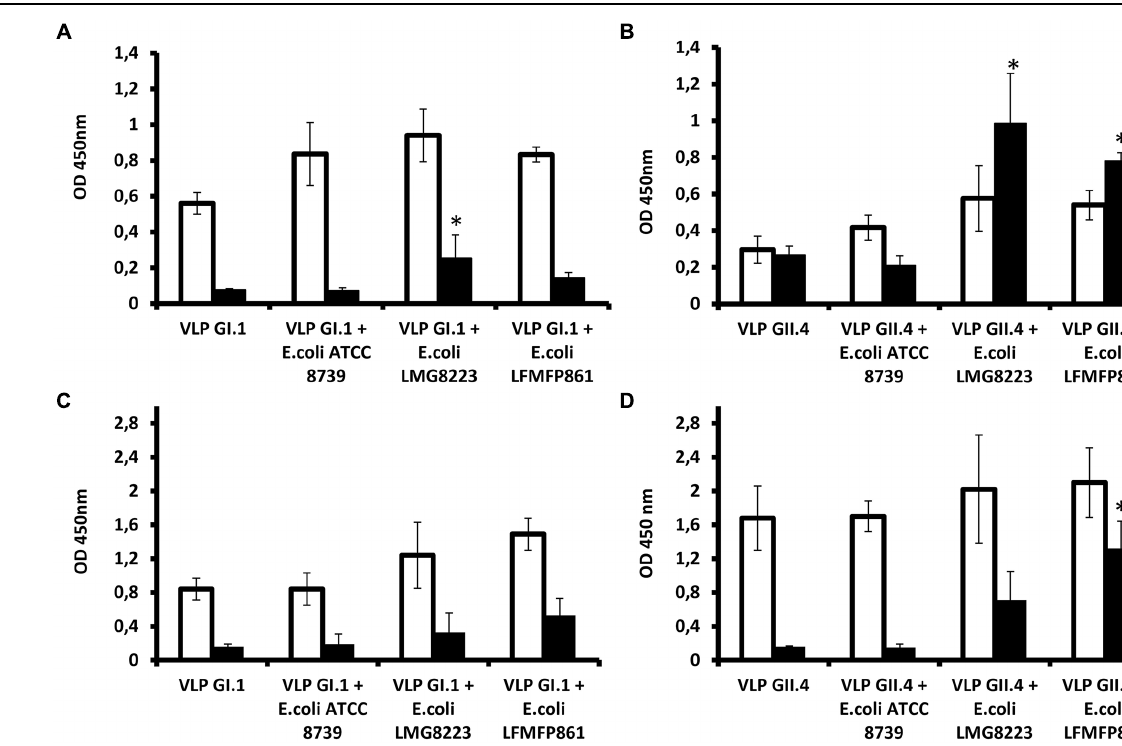
FIGURE 2 | Protection of histo-blood group antigen (HBGA) expressing bacteria on human norovirus (NoV) virus-like particles (VLPs) toward heat treatment. (A,B) Antigenicity detection of NoV GI.1 and GII.4 in the absence of bacteria, in the presence of non-HBGA expressing E. coli ATCC8739 or HBGA-expressing E. coli LMG8223 and LFMFP861 before (white bars) or after (black bars) heat treatment at 90 ◦ C for 2 min. (C,D) Mucin-binding